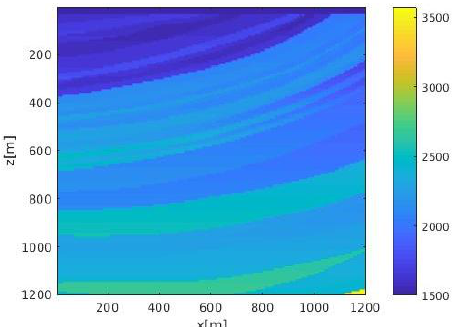
Figure 11. Marmousi velocity model.